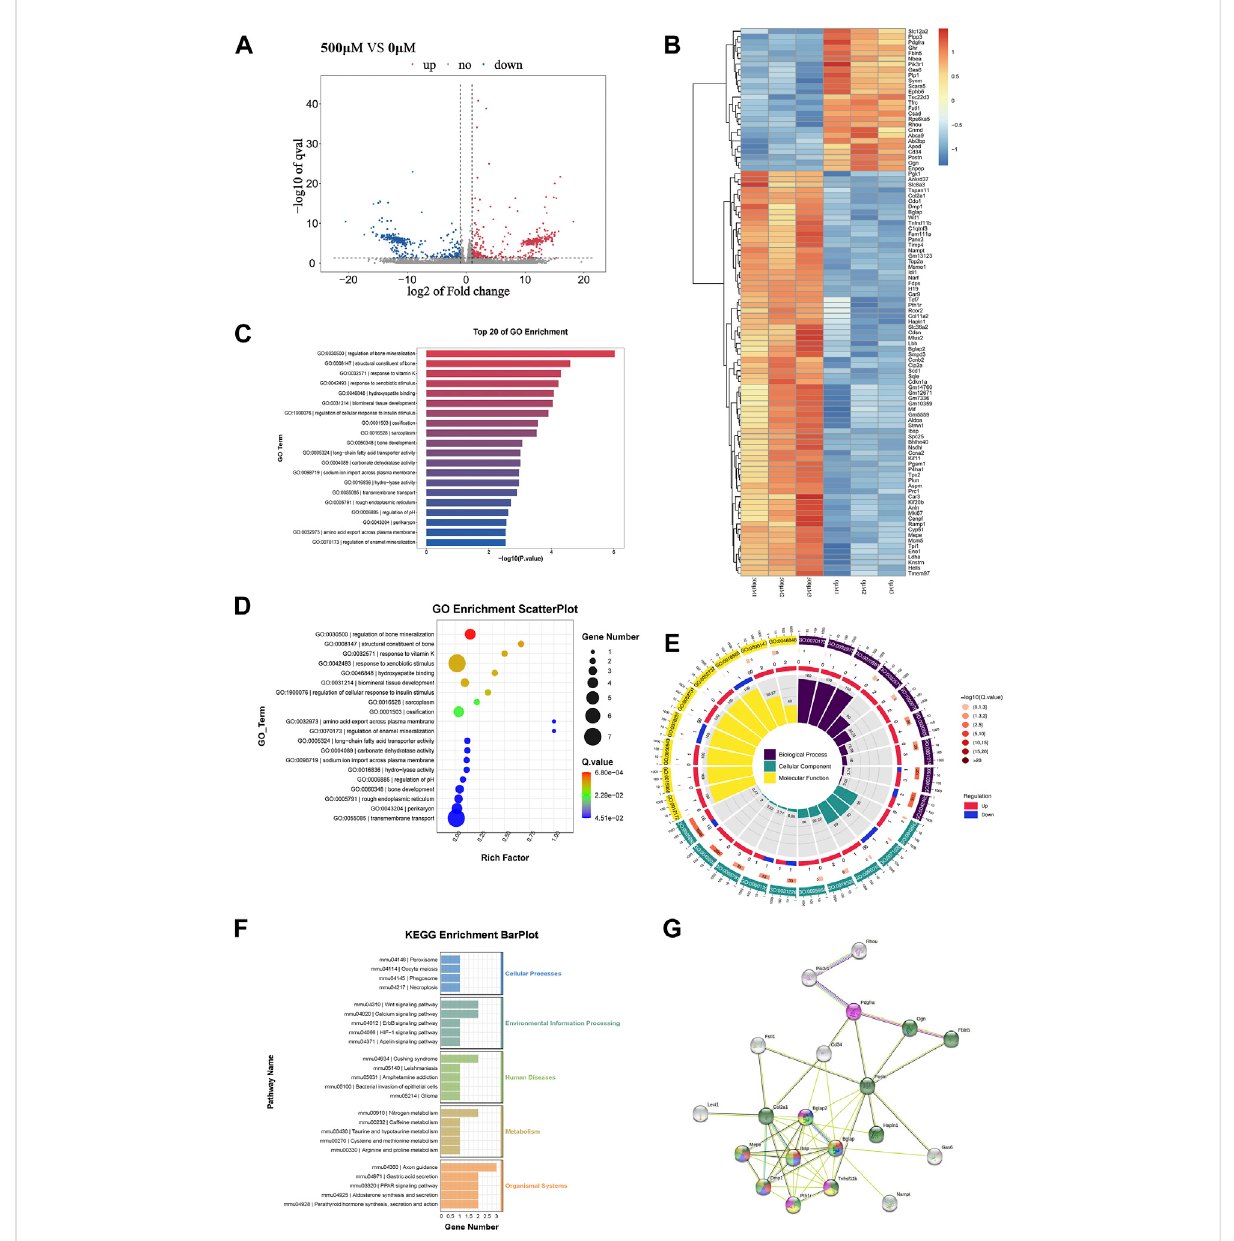
FIGURE 3 The results of RNAseq between 0 μ M Met/ α -CSH/nHA and 500 μ M Met/ α -CSH/nHA.The differentially expressed genes between 0 μ M group and 500 μ M are shown in volcano (A) and heatmap (B) . GO Scatterplot, top 20 of GO enrichment and GO loopcircos are shown in (C – E) . KEGG enrichiment barplot is shown in (F) . The correlation of protein interactions predicted by differential protein is shown in (G)